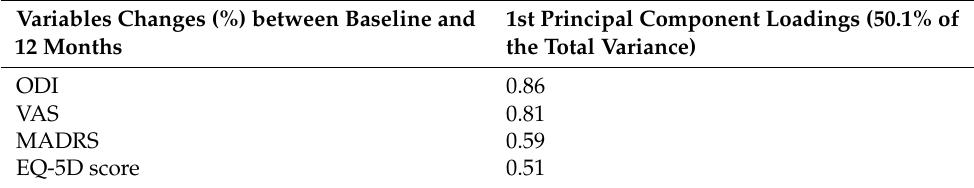
1st Principal Component Loadings (50.1% of the Total Variance)